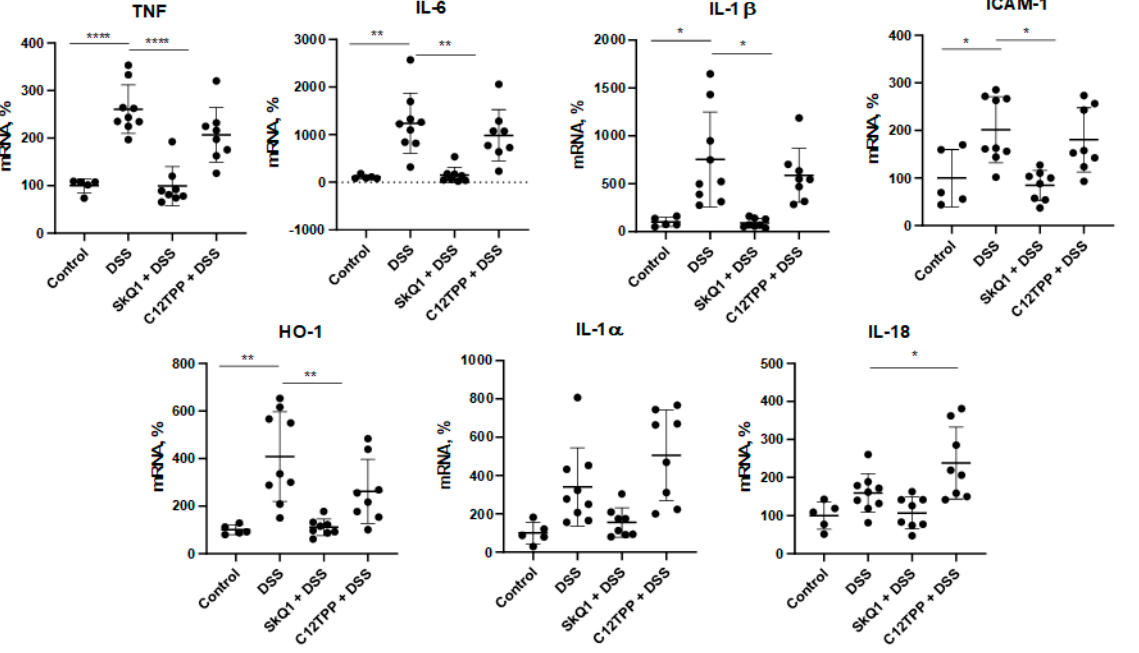
Figure 3. Effect of SkQ1 and C 12 TPP on gene expression of pro-inflammatory molecules in the proximal colon in mice with DSS-induced colitis. Animal groups are indicated in Figure 1. Results are expressed as mean ± SD (n = 5 − 9). * p < 0.05, ** p < 0.01, **** p < 0.0001 as compared with the DSS-treated mice.